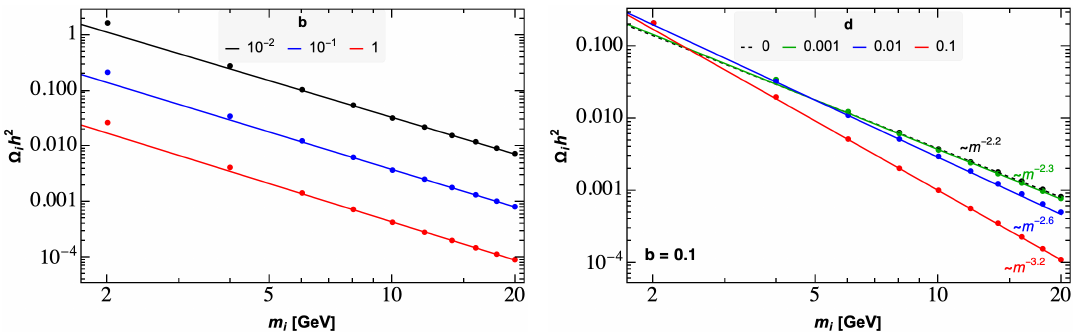
Figure 7 . Individual abundances with DM mass in the heavy mediator case , without ( left panel ) and with ( right panel ) conversions, for N = 10 , with Λ ∼ 100 GeV